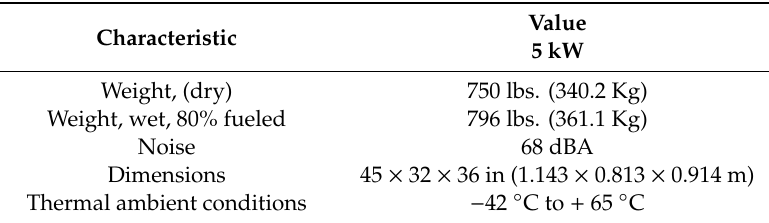
Table 1. As per military standards.